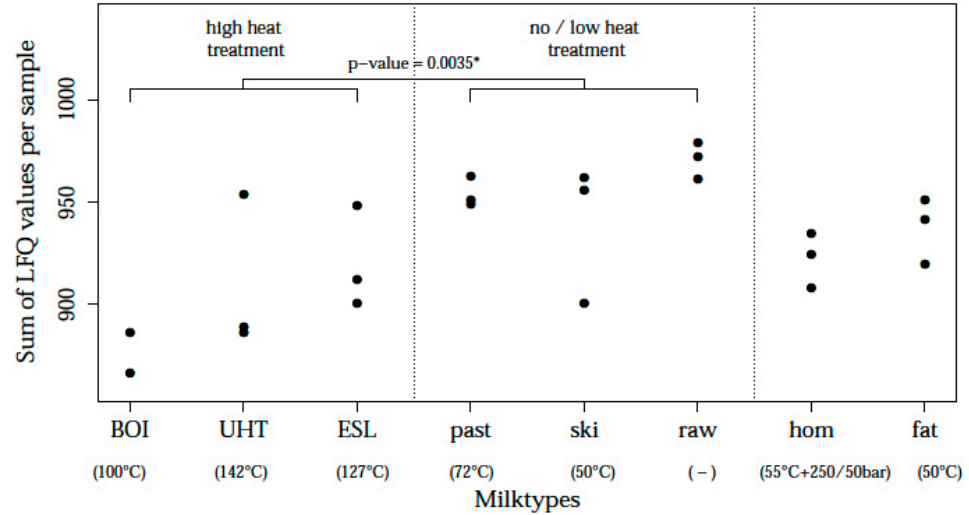
Figure 4. Total protein contents (sum of LFQ values per sample) in differently processed milks. * p -value derived from a logistic regression with adjustment for milk batch.